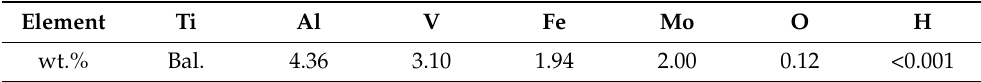
Table 1. The chemical composition of SP700 titanium alloy (wt.%). Element